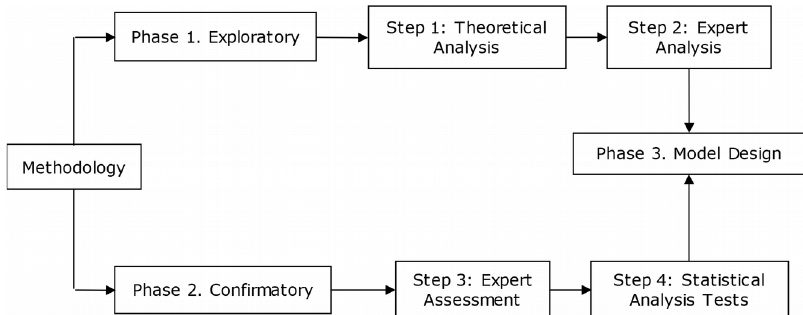
Figure 1. Methodology for the identification of essential